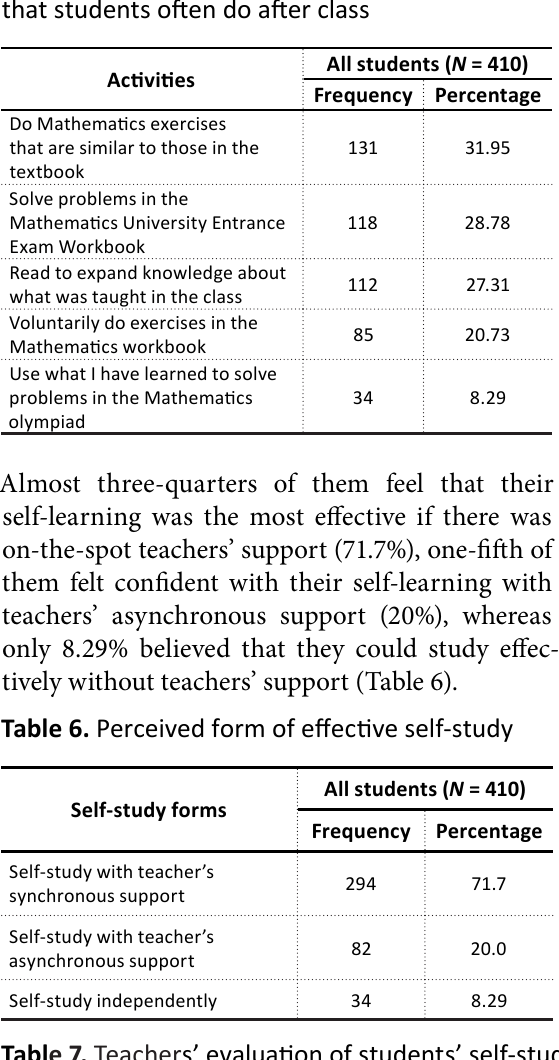
Table 5 (cont.). Mathematics self-study activities